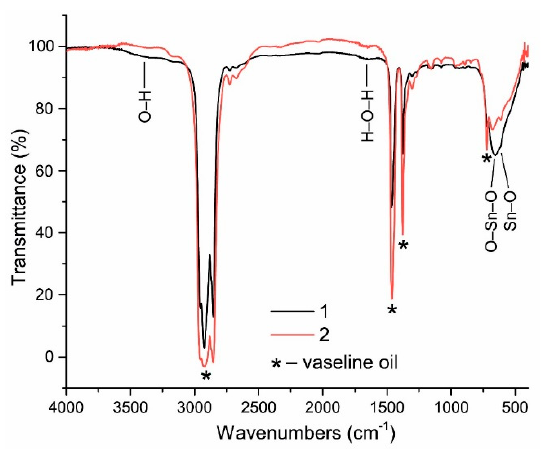
Figure 6. FTIR spectra of as-synthesized (1) and annealed (2) powders measured at room temperature.